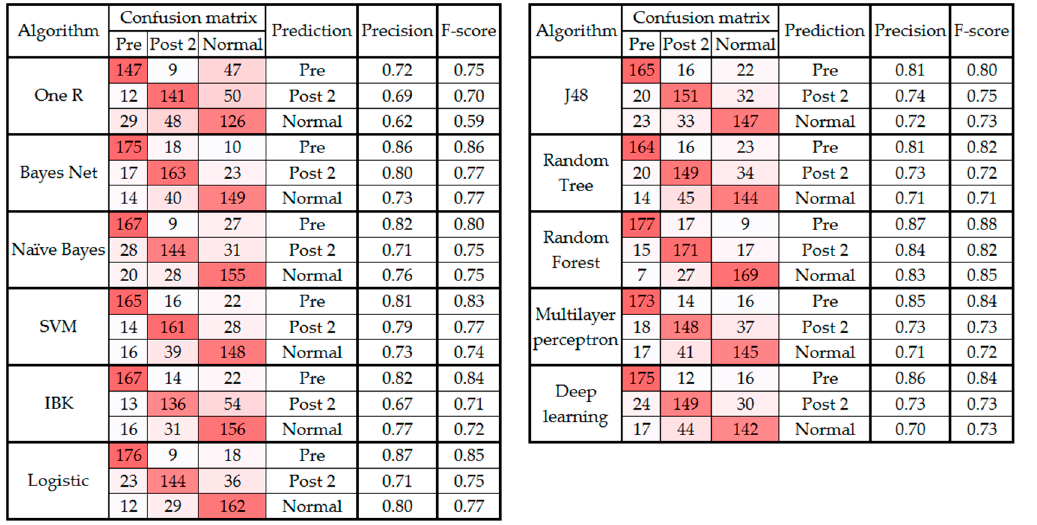
Figure 4. Confusion matrix, precision, and F ‐ score from classification algorithms classifying data into three classes after feature selection.